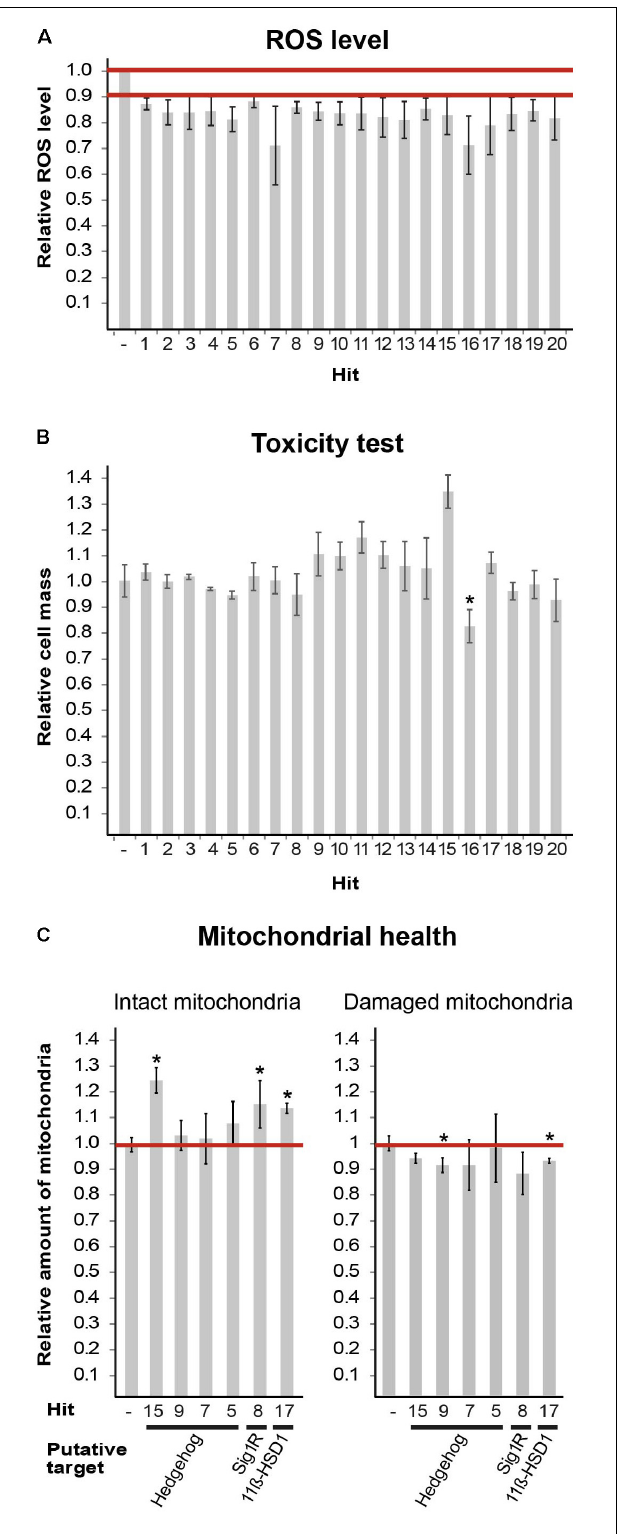
FIGURE 1 | Hits obtained from DIVERSet TM -EXP library. (A) Mut MEFs treated with the indicated compounds at 10 µ M for 24 h followed by